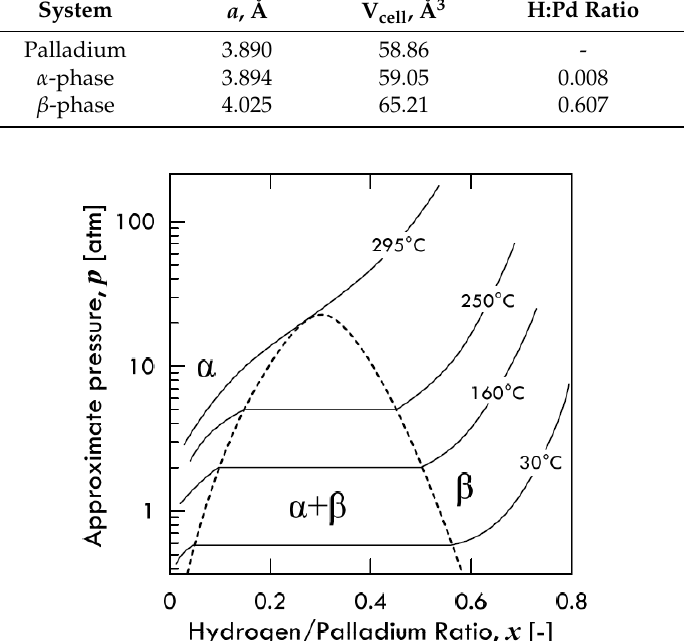
Figure 11. Approximate Pressure-Composition-Temperature phase diagram for the Pd-H system. Adapted from Knapton [45].